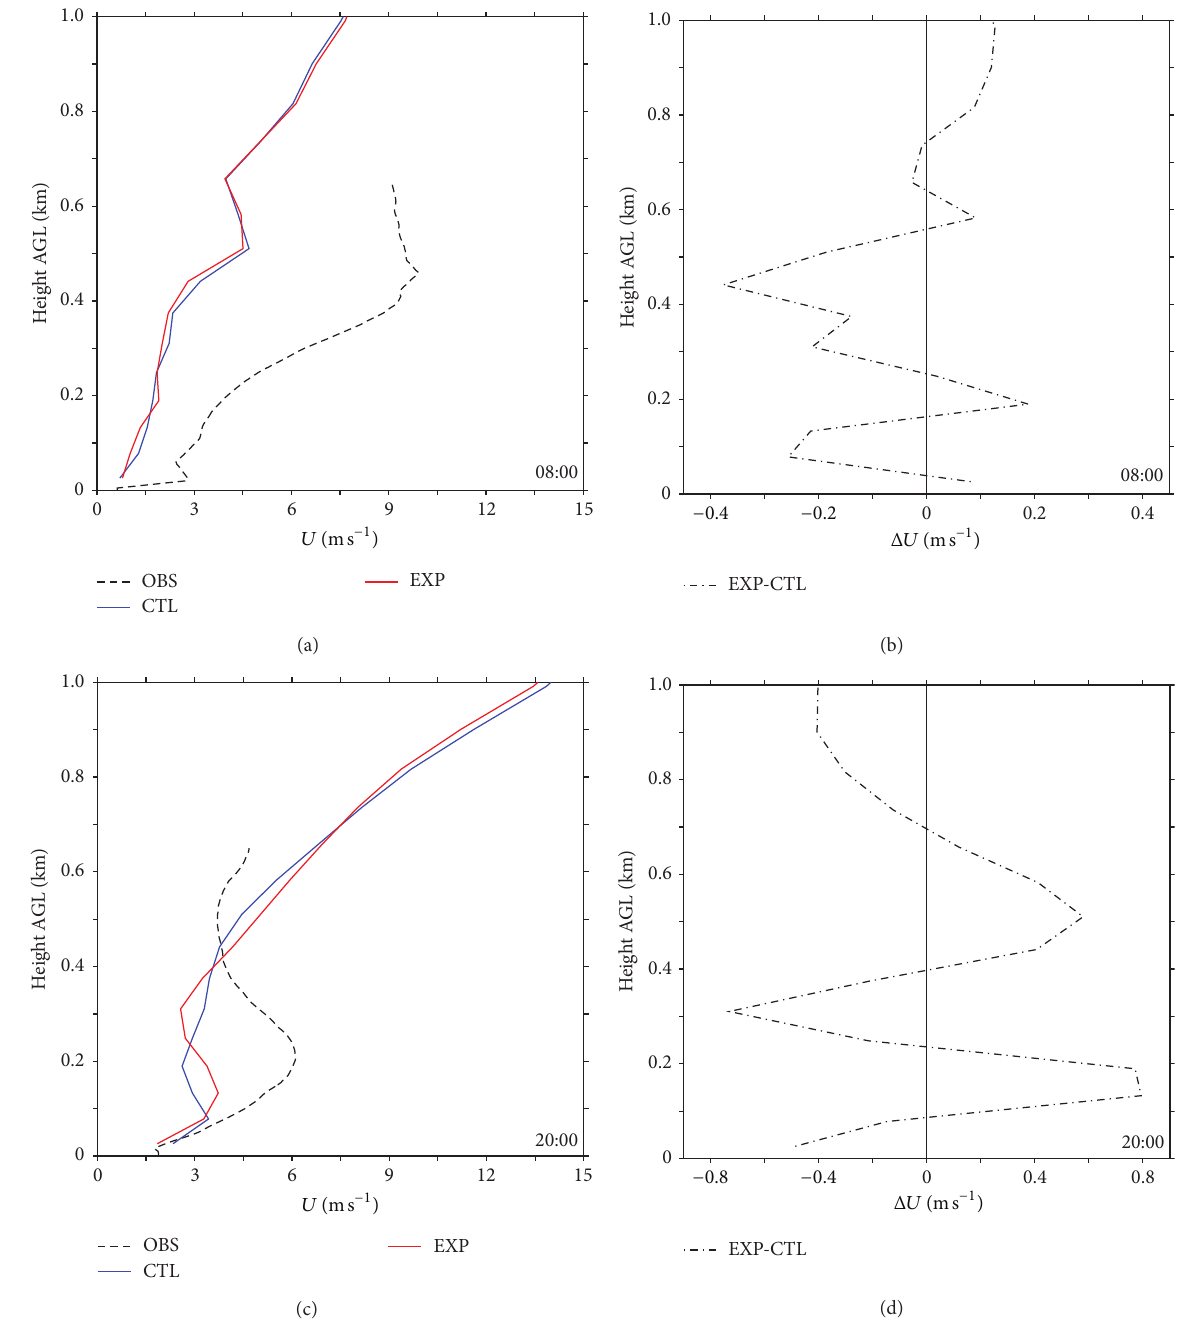
Figure 6: (a) Observed and the simulated mean wind speed ( m s −1 ) profile at Fangzhuang, and (b) differences between the EXP run and the CTL run at 0800 LST 28 February 2001. (c) and (d) are, respectively, the same as (a) and (b), but for 2000 LST 28 February